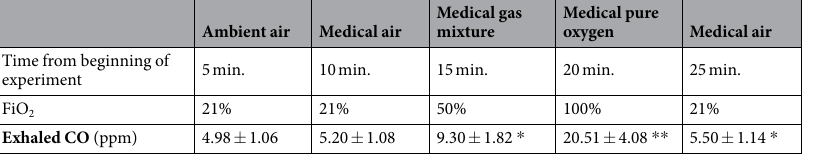
Table 1. Exhaled Carbon Monoxide values measured by the ProCeas in healthy volunteers (smokers and non- smokers together). ** p < 0.001 Exhaled CO with FiO 2 100% versus every other situation. * p < 0.01 Exhaled CO with FiO 2 50% versus ambient air or medical air (FiO 2 21%). Comparisons by paired t test, for n =